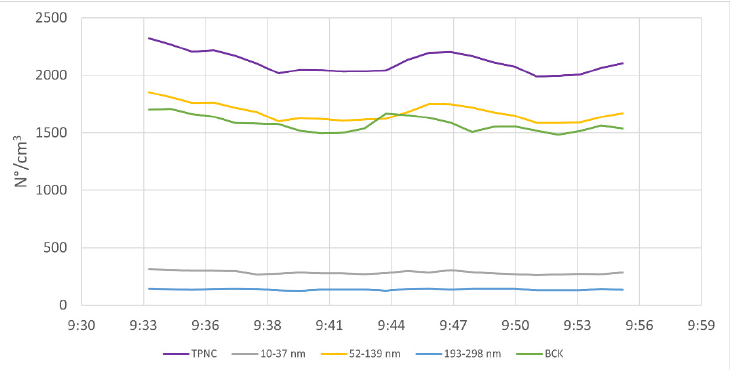
Figure 3. TPNC trends and the main particle size classes for O2–loading of the metal powder on the EOS 290 M with a closed system.